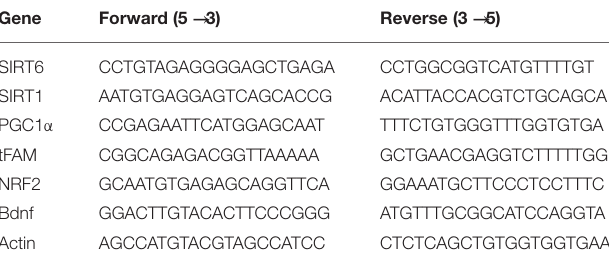
TABLE 1 | Primer sequences.